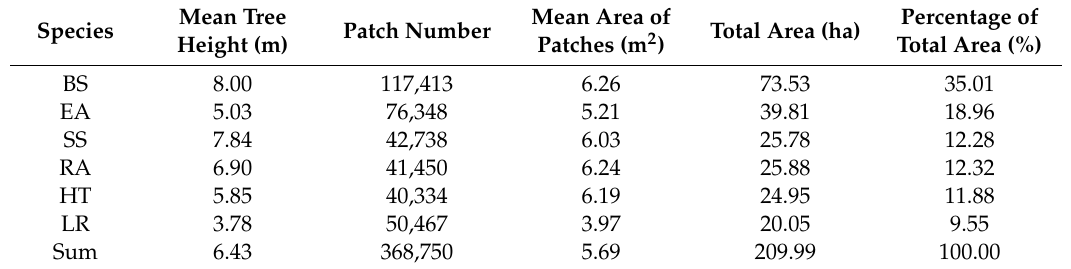
Table 7. Characteristics of tree patch in di ff erent mangrove species in the whole study